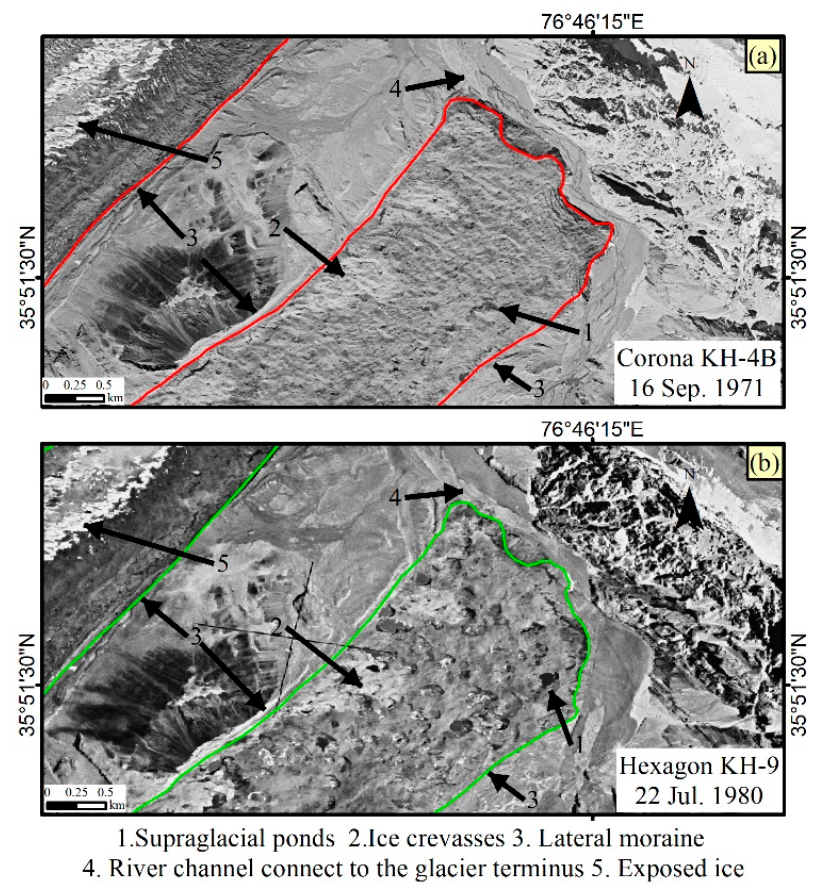
Figure 5. Examples of manual digitizing the debris-covered glacier in this study. Debris-covered glacier boundary was identified based on distinct supraglacial debris futures (1–5) using Corona ( a ) and Hexagon images ( b ).